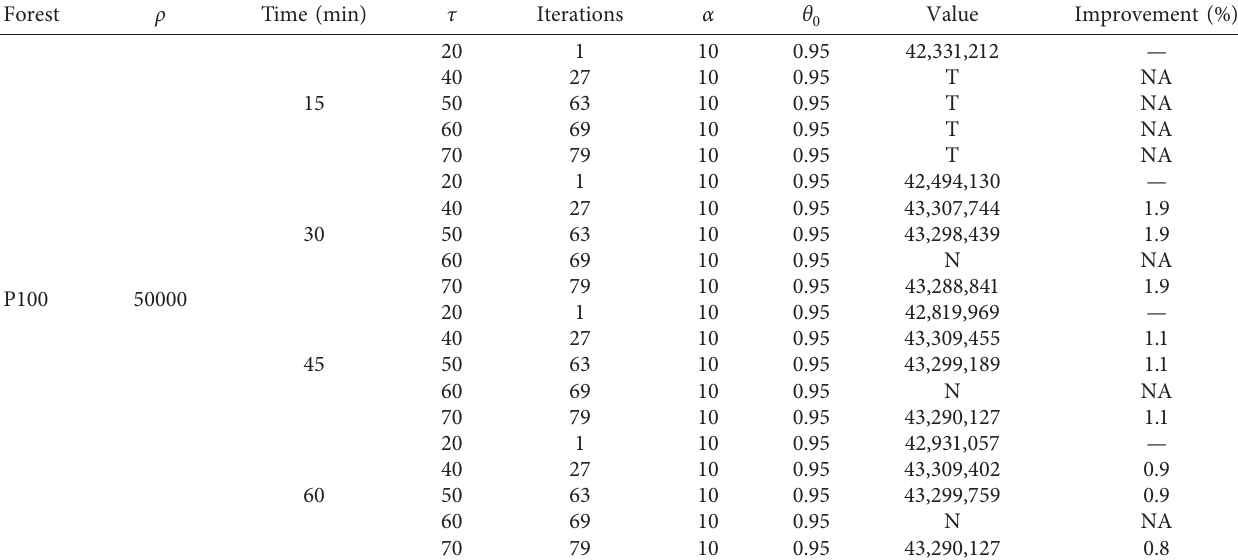
Table 9: Effects of τ and allocated time for the forest